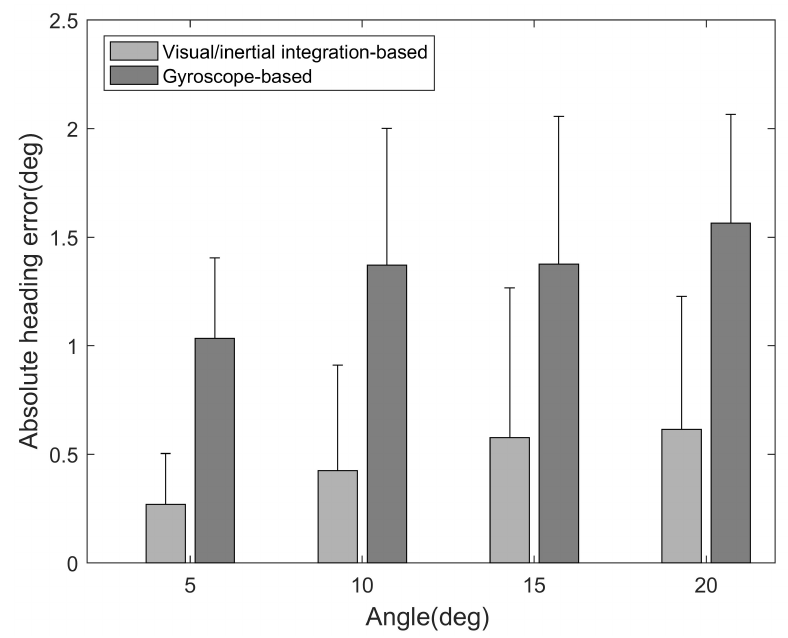
Figure 6. The errors of two heading angle estimation methods.